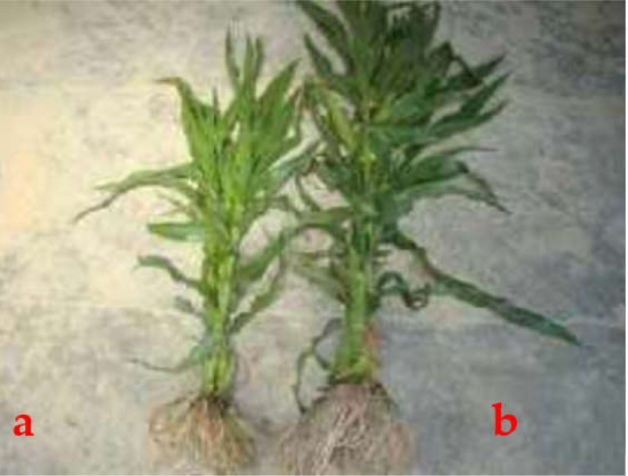
Figure 3. Effect of tractor wheeling on root system ( a ) trafficked and ( b ) non-trafficked experimental plots [117].